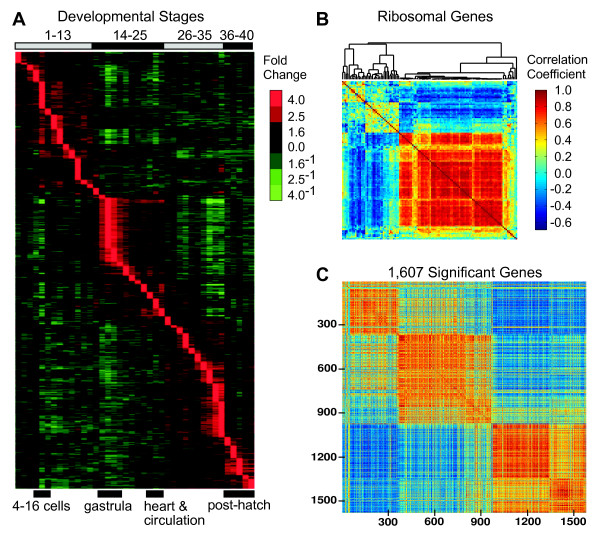
Peak expression and correlations throughout development. A. Gene expression profiles ordered by peak expression throughout development. Separate peaks were defined as within the 90% CI of the maximum transcript level measured and at least three stages away from another peak. All genes that changed significantly between any two stages (6,651 of 6,857, 97%) were ordered to gain a broad overview of gene expression throughout development. Most genes (57%) show one peak during development, 30% have two peaks, and 13% have three or more distinct peaks. 4-16 cells encompass stages 4-6. Gastrula encompasses stages 15-18. Heart and circulation encompass stages 25-23. Post-hatch encompasses stages 36-40. B. Correlations of ribosomal genes. Correlation coefficients > 0.4 and < -0.4 are significant at p < 0.01. Red indicates positive correlations and blue indicates negative correlations. The large group of highly positively correlated ribosomal genes has peak expression during pre-mid gastrula. C. Correlations among 1,607 genes significantly differently expressed across all stages (ANOVA, p < 0.01) arranged by peak order. Numbers along the left side and bottom delineate numbers of genes. Correlation coefficients > 0.4 and < -0.4 are significant at p < 0.01. Colors as in 2B.